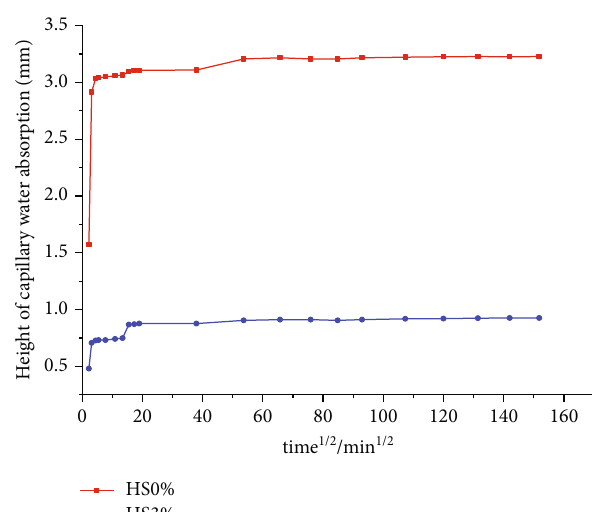
Figure 2: Specimens with fi lled fi ssures.